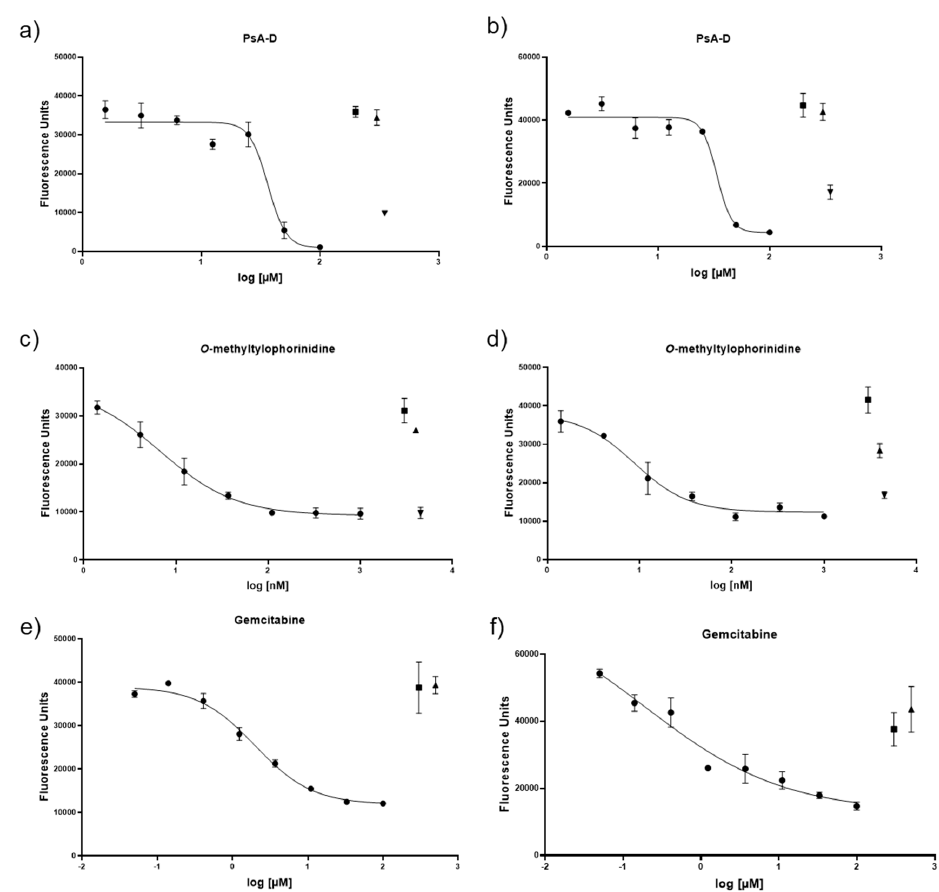
Figure 3. Comparison of the cell viability response curves for the two pancreatic cancer cell lines exposed to pseudopterosin A-D (PsA-D), O -methyltylophorinidine (TYLO), or gemcitabine (GEM) in a